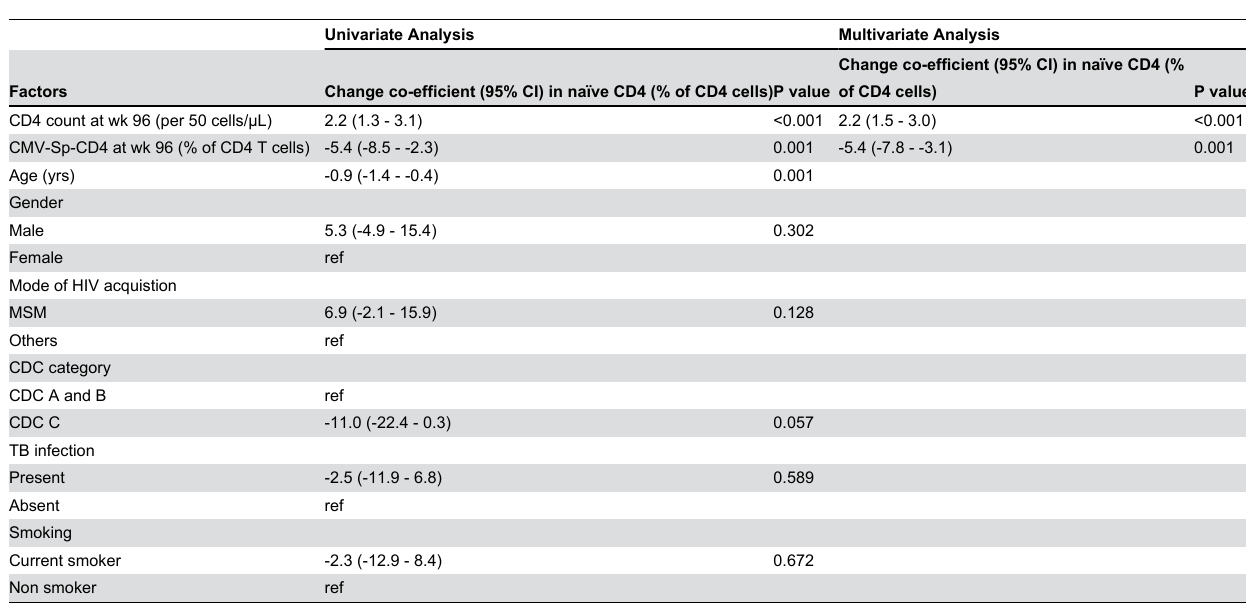
Table 3. Factors associated with the frequency of naïve CD4 T